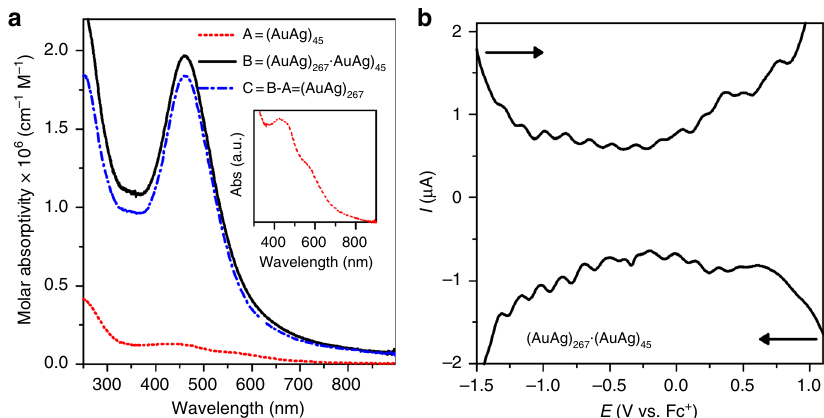
Fig. 4 Optical and electrochemical properties of (AuAg) 267 ∙ (AuAg) 45 . a Molar absorptivity spectra of (AuAg) 267 ∙ (AuAg) 45 cocrystal, plasmonic (AuAg) 267 , and molecule-like (AuAg) 45 clusters dissolved in CH 2 Cl 2 . Inset plot is the enlarged view of UV-Vis spectra of (AuAg) 45 . b DPV curves of (AuAg) 267 ∙ (AuAg) 45 cocrystal dissolved in CH 2 Cl